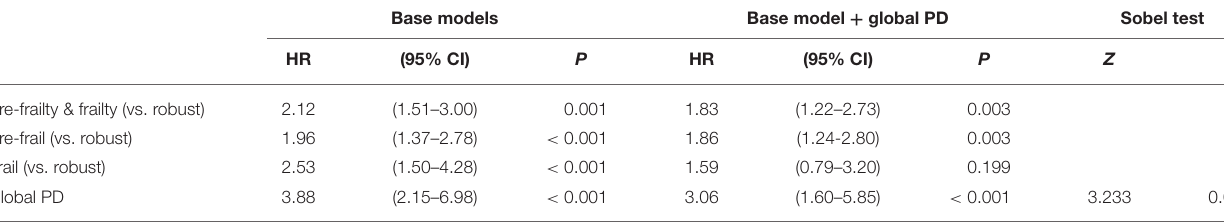
TABLE 3 | Association of physical frailty and physiological dysregulation (PD) with mortality ( N = 2,906).